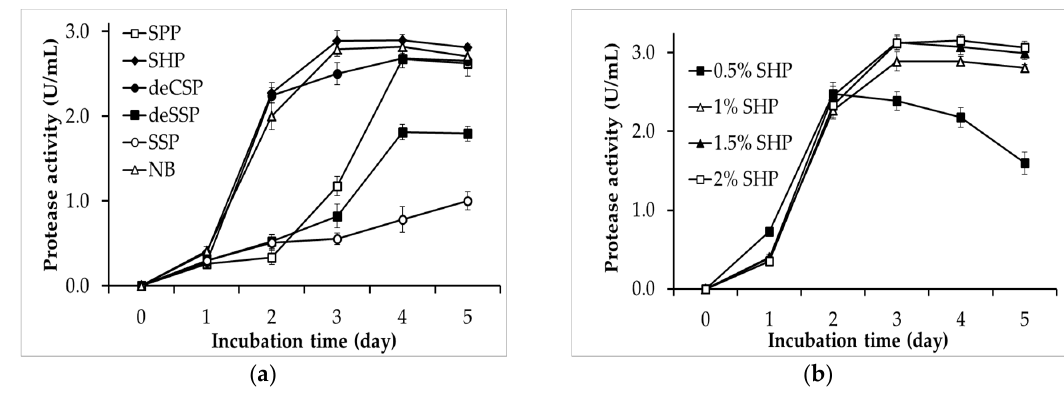
Figure 1. Effects of ( a ) temperature and ( b ) pH on the activity and stability of P. mucilaginosus TKU032 chitosanase. The error bar is the standard deviation of three